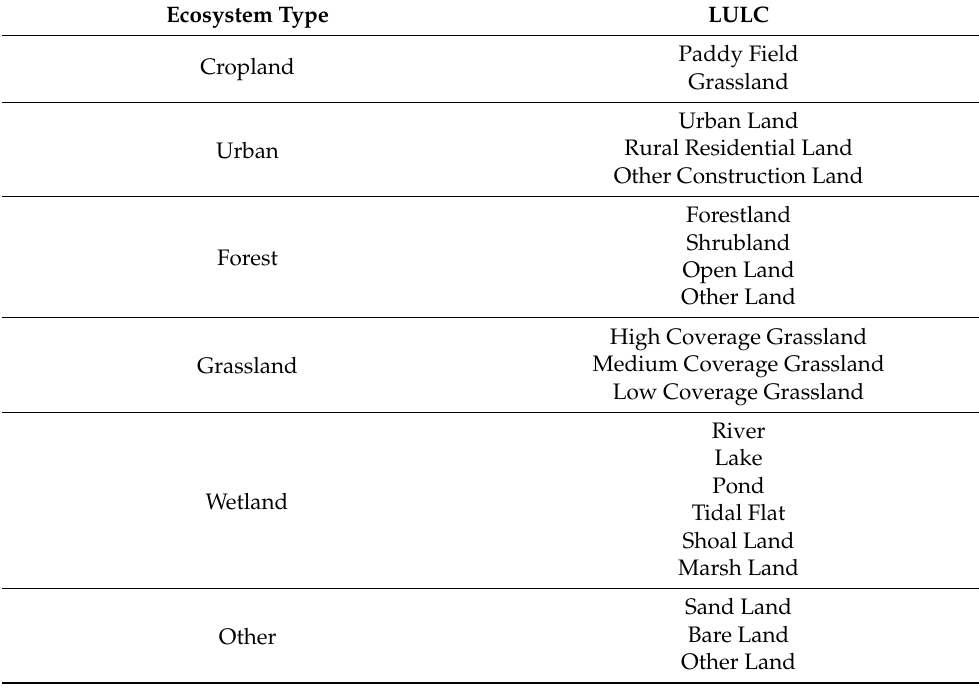
Table 2. Ecosystem Type and Land Use and Land Cover (LULC)